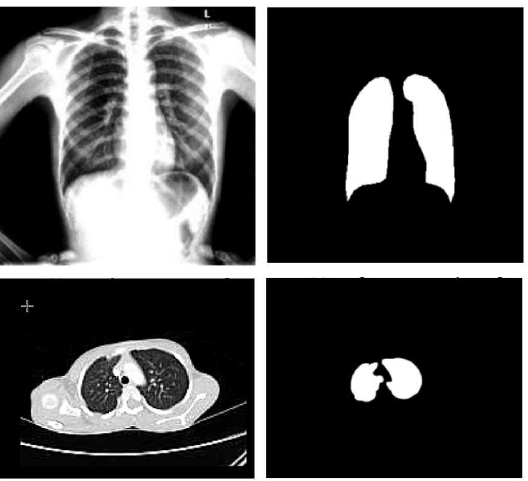
Figure 3. Sample X-ray and CT images before and after the segmentation